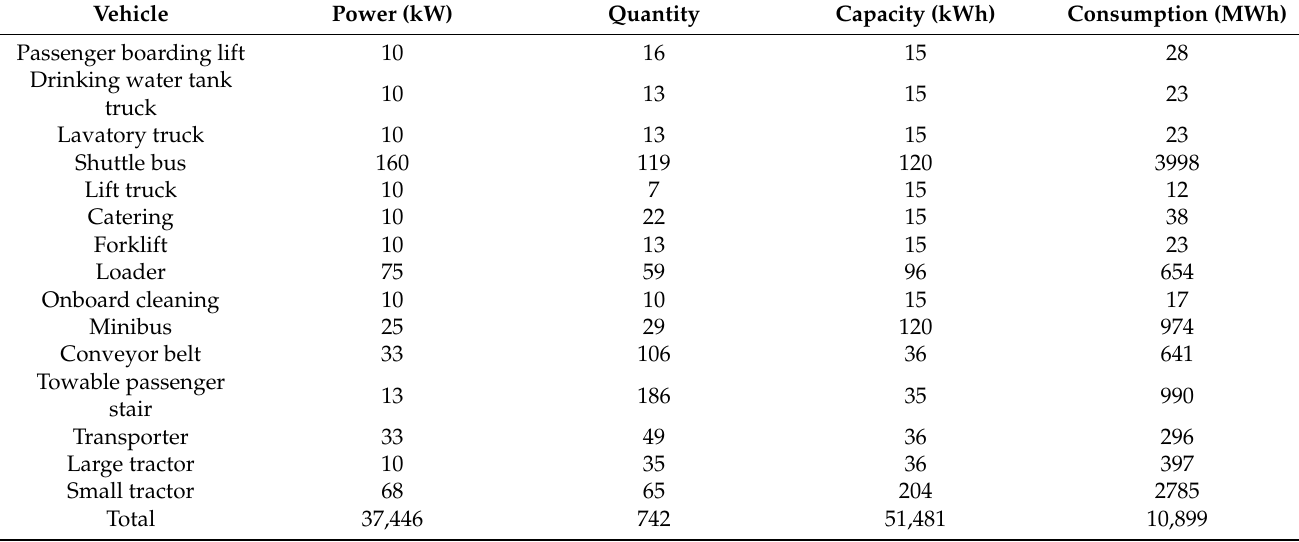
Table 5. Airside vehicles in Fiumicino airport: main